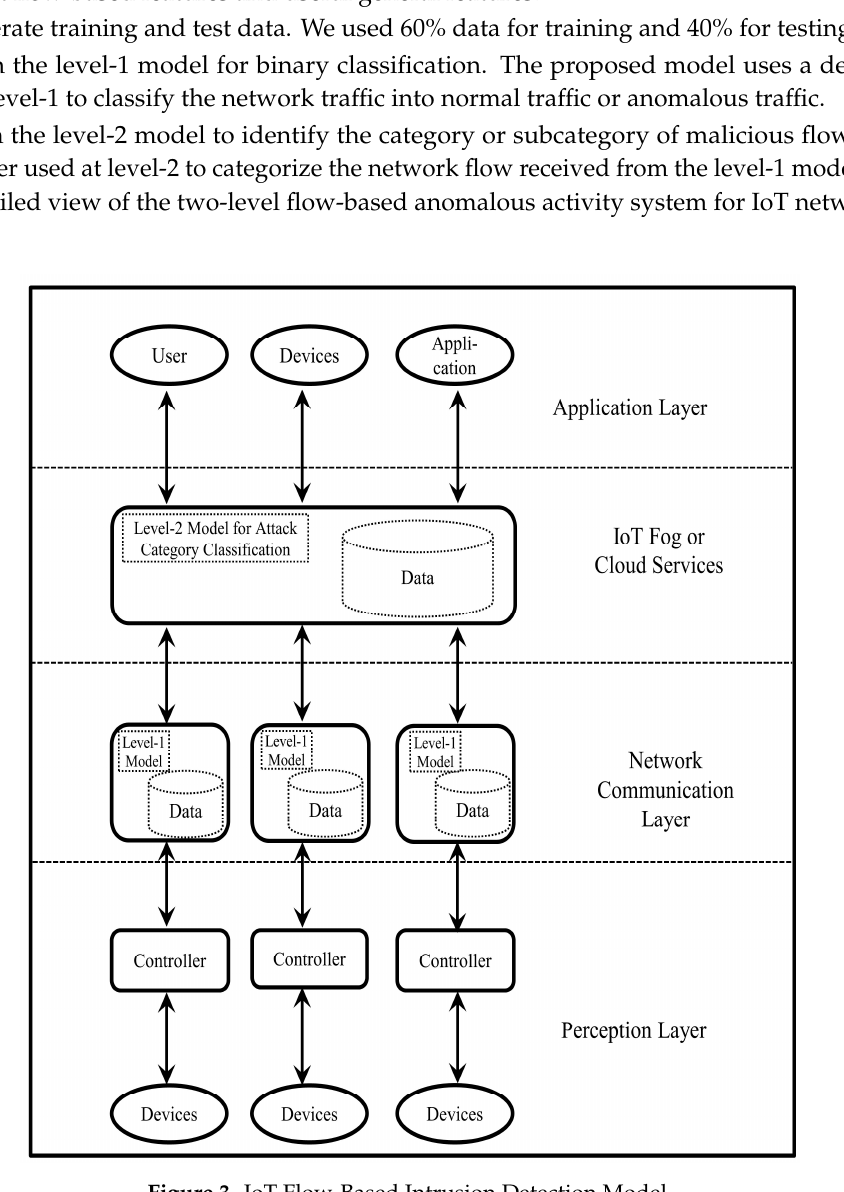
Figure 3. IoT Flow-Based Intrusion Detection Model.